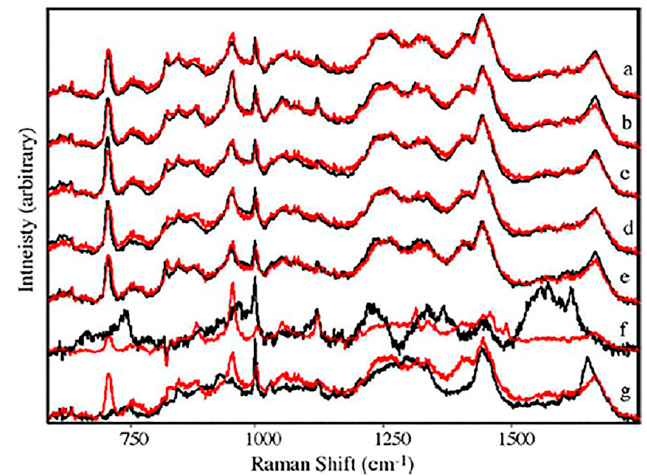
Figure 9. The average Raman spectra of five semen samples (black) with the fitted spectroscopic signature (a–e), and the Raman spectra of blood (f) and saliva (g) with the fitted spectroscopic signature [128].